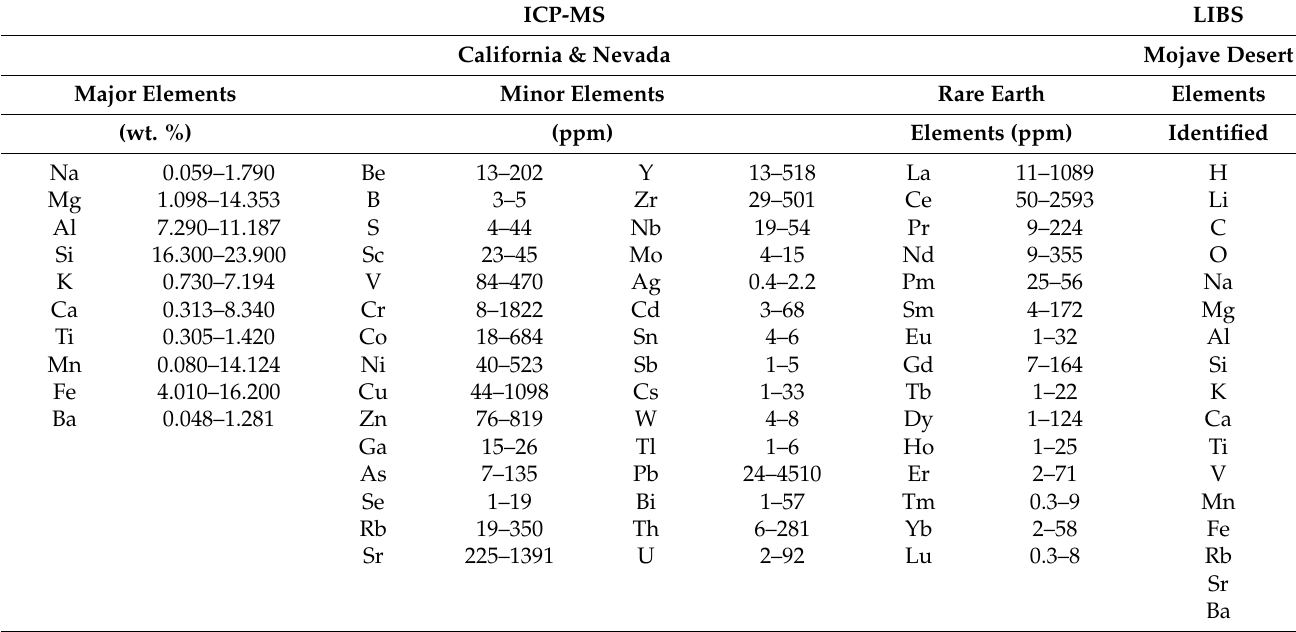
Table 1. Geochemical characteristics of rock varnish from California and western Nevada determined from the ICP-MS analysis compared with the elements identified in rock varnish across the Mojave Desert by LIBS. ICP-MS LIBS California & Nevada Major Elements Minor Elements Rare Earth